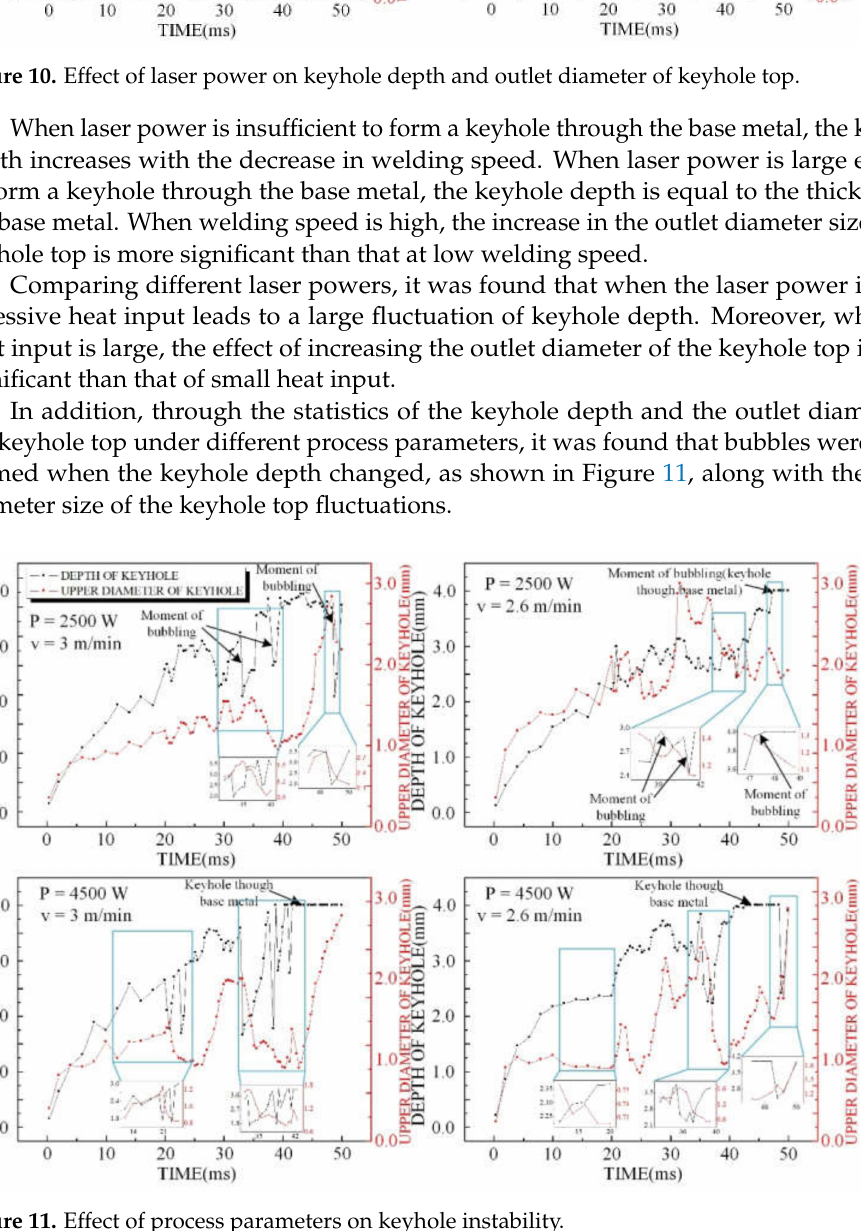
Figure 11. Effect of process parameters on keyhole